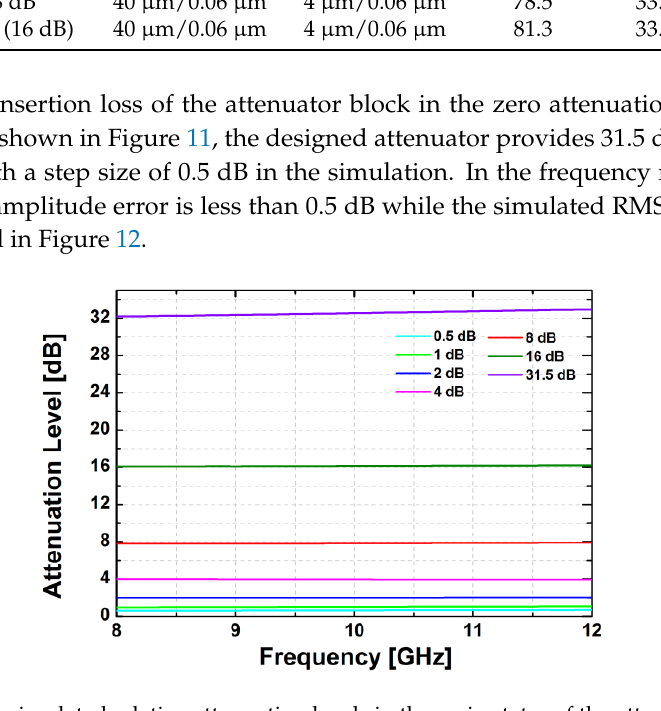
Figure 11. The simulated relative attenuation levels in the main states of the attenuator block.